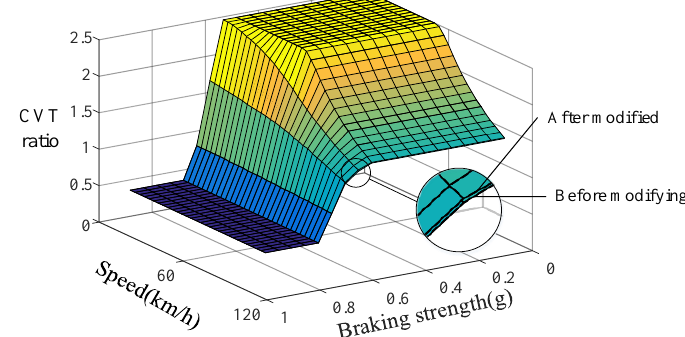
Figure 10. CVT ratio map before and after modifying.